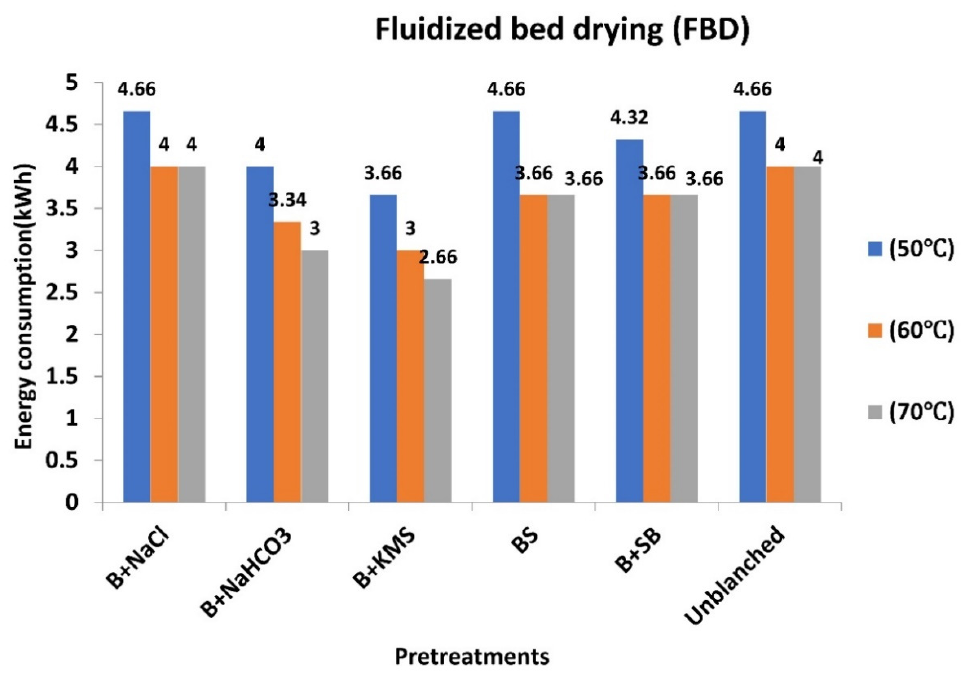
Figure 7. Energy consumption under various pretreatments and drying temperatures in fluidized bed dryer.